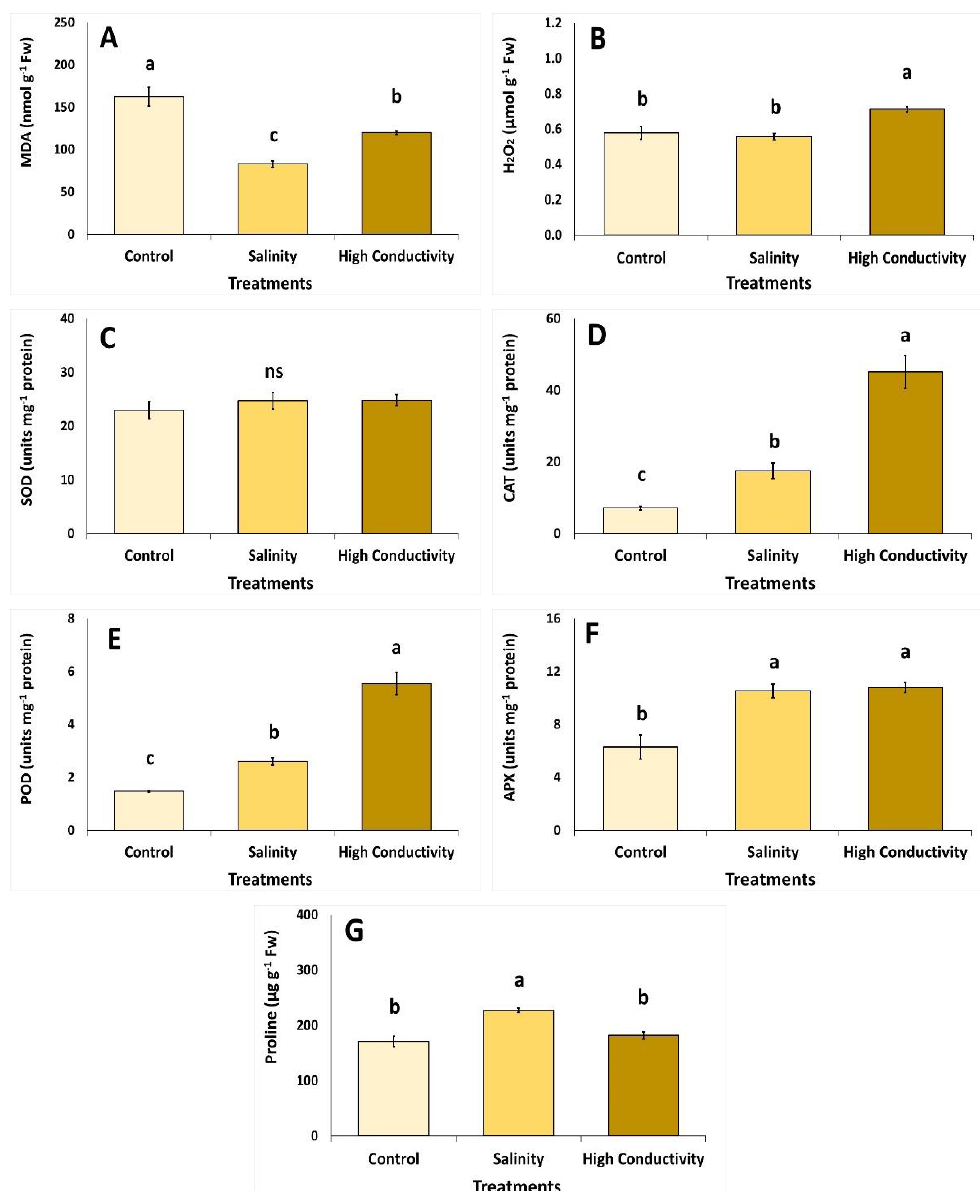
Figure 6. Influence of salinity (75 mM NaCl) and high conductivity (8.5 dS m −1 ) on the leaf damage index, proline and enzyme antioxidant activities on geranium grown in perlite. ( A ) lipid peroxidation—MDA, ( B ) hydrogen peroxide—H 2 O 2 , ( C ) superoxide dismutase—SOD, ( D ) catalase—CAT, ( E ) peroxidase activity—POD, ( F ) ascorbate peroxidase—APX and ( G ) proline. Significant differences ( p < 0.05) are indicated by different letters. Error bars show SE (n = 4). In verbena plants, salinity treatment increased MDA, SOD, POD, APX and proline